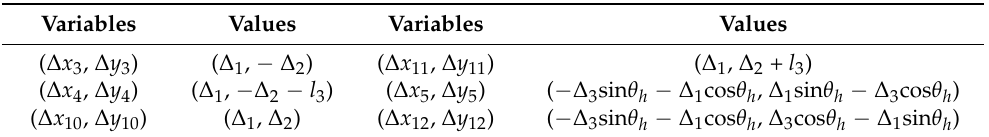
Table 2. The mass center position of a rigid body with respect to the j -end or k -end of the i th flexure element. Variables Values Variables